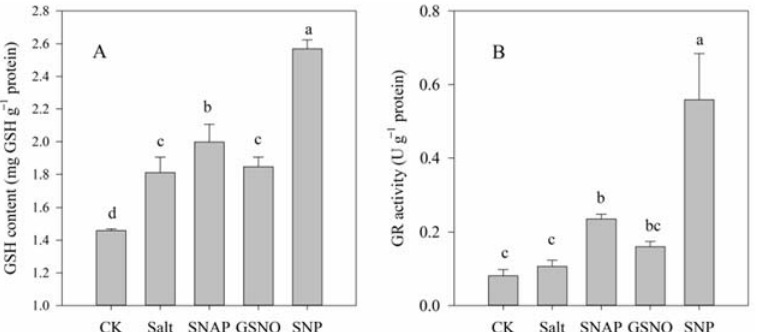
Figure 4. Glutathione (GSH) content ( A ) and glutathione reductase (GR) activity ( B ) of C. paliurus leaves under different treatments. CK (control, distilled water), salt (100 mM NaCl), SNAP (100 mM NaCl with 0.05 mM SNAP), GSNO (100 mM NaCl with 0.05 mM GSNO), SNP (100 mM NaCl with 0.05 mM SNP). Bars represent standard deviation (SD) of the means. Different letters suggest significant differences among the treatments at p < 0.05 (Duncan’s test).